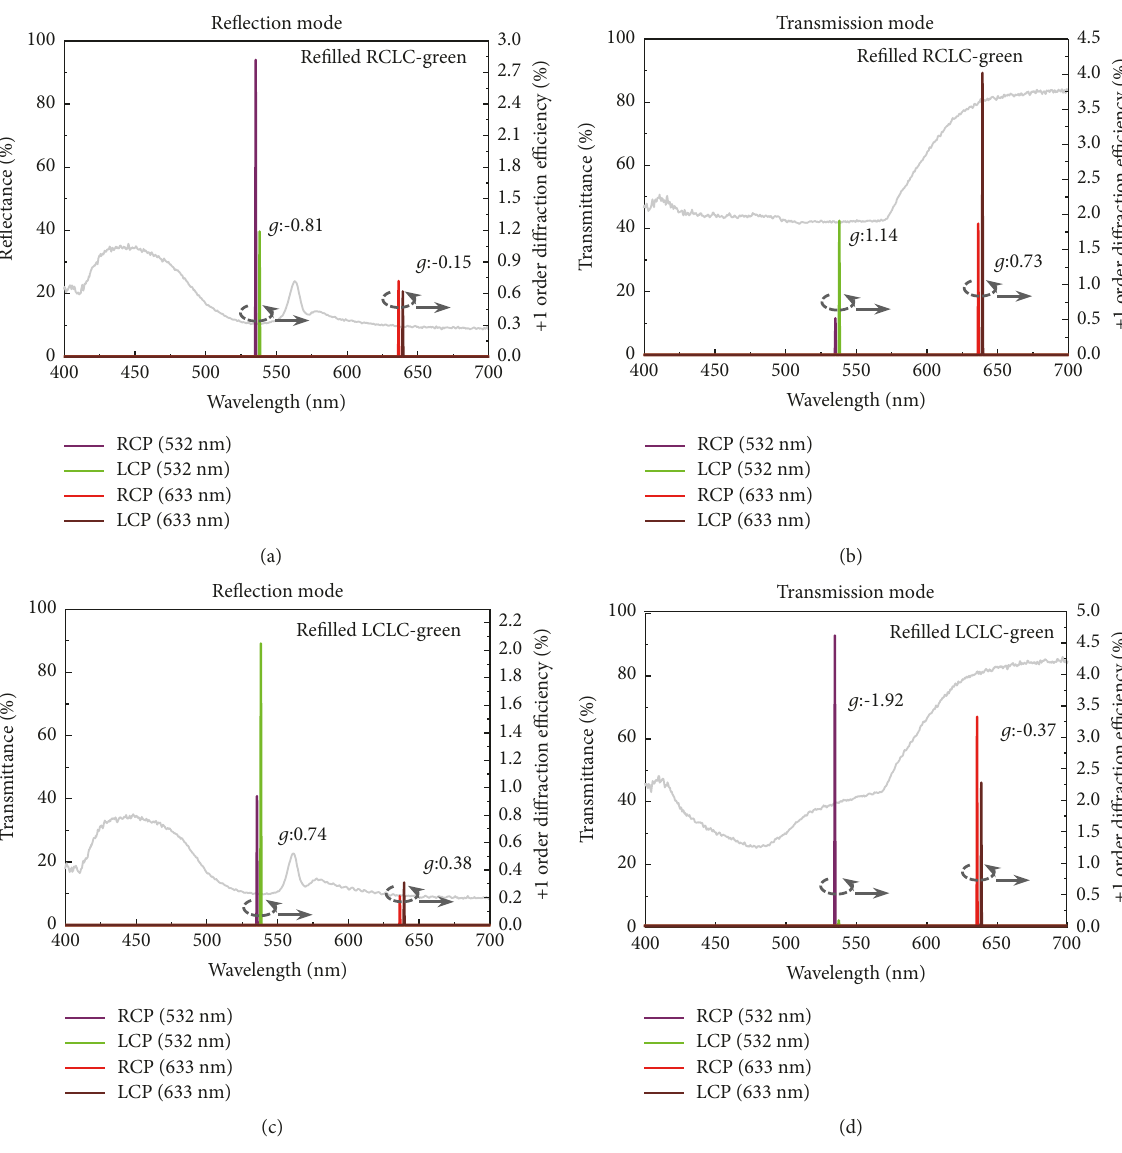
Figure 3: Measured +1 order diffraction efficiencies of the refilled CLC template grating in (a)/(c) reflection mode and (b)/(d) transmission mode by the RCP and LCP lights with the wavelengths of 532 and 632 nm, respectively. The refilled material is RCLC-green in (a)/(b) and LCLC-green in